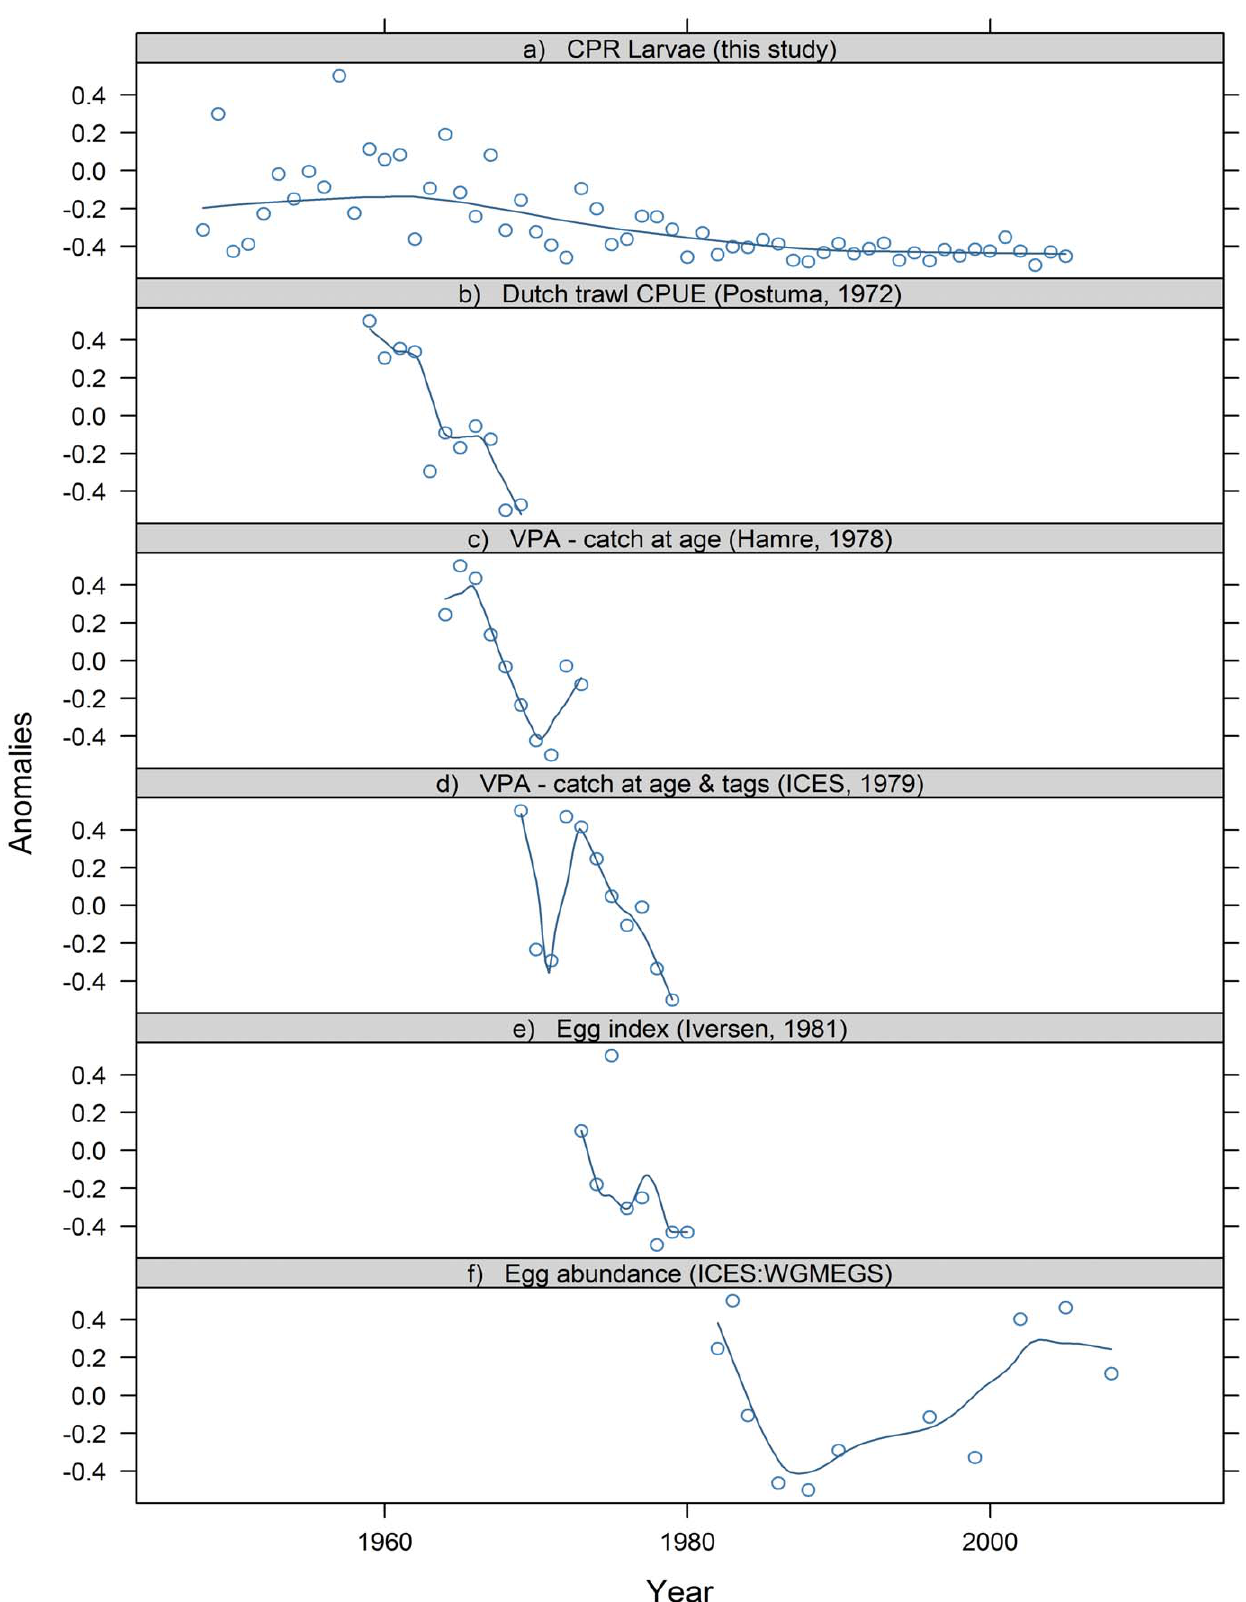
Figure 7. Long term mackerel trends in the North Sea [ 6,27–29 ] . Loess smoothed trend lines with span=0.5.